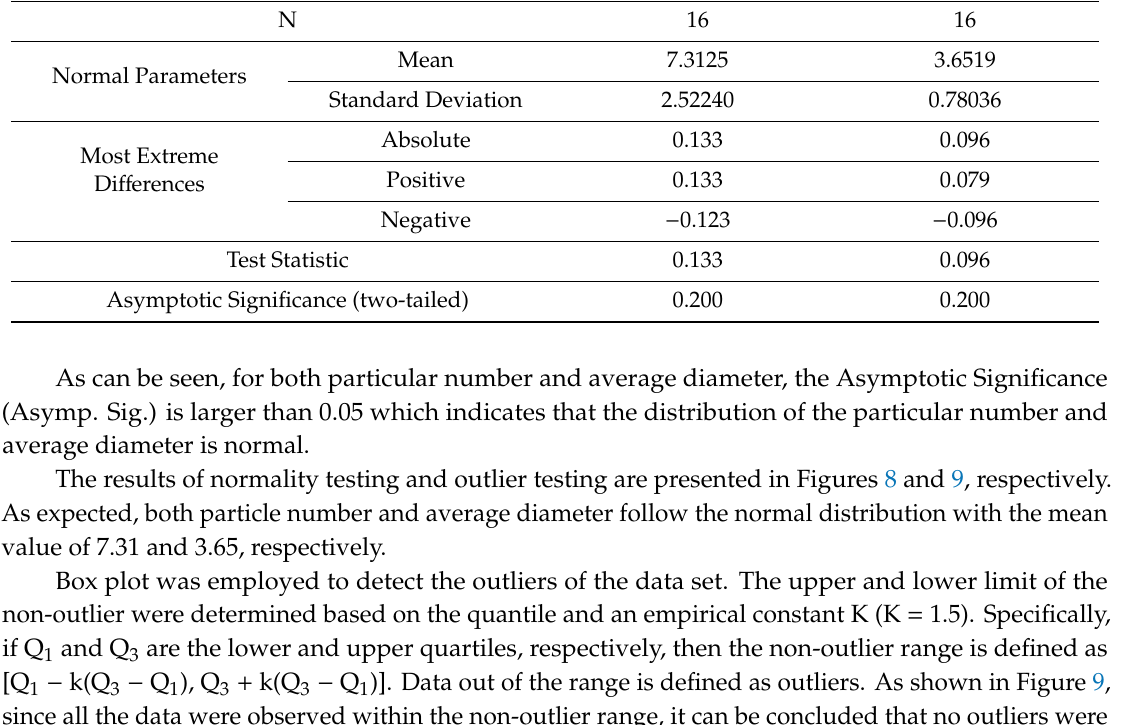
Table 6. Results of Kolmogorov – Smirnov test